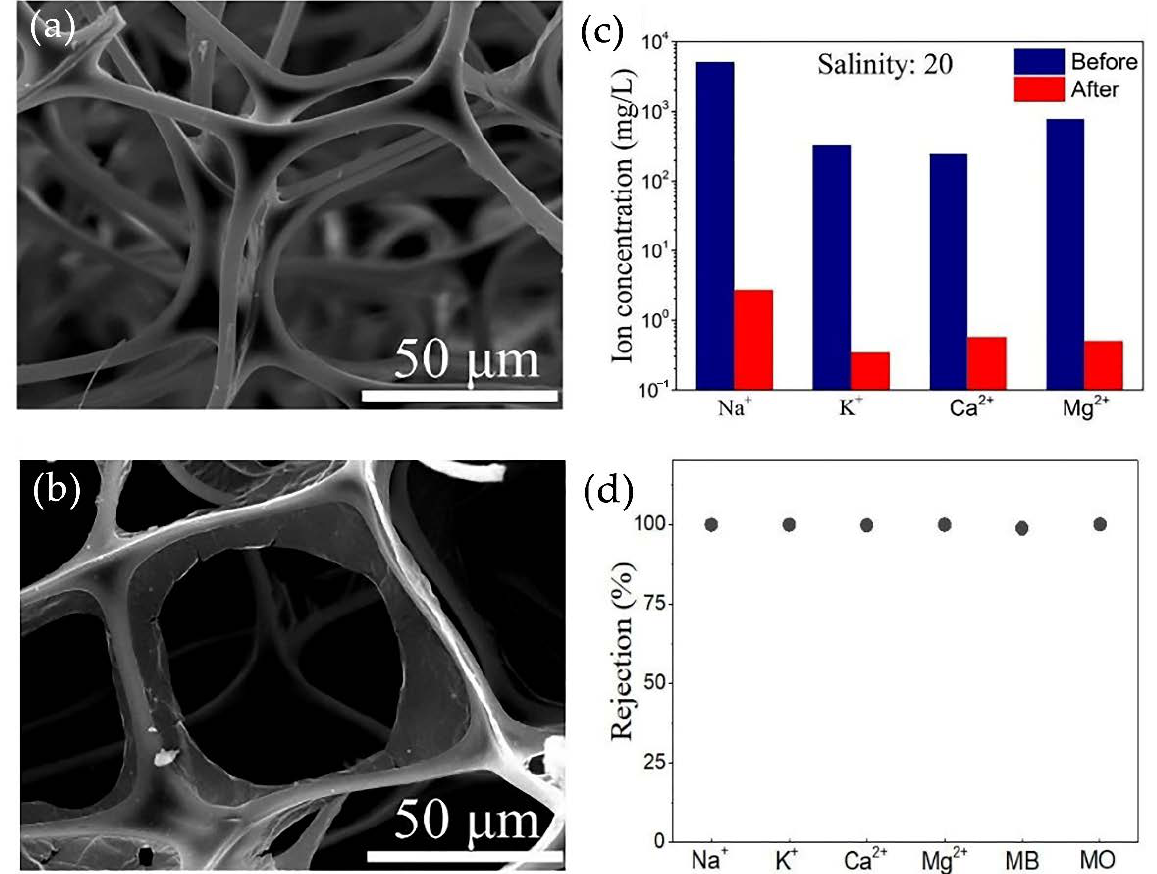
Figure 29. SEM images of melamine foam ( a ) before and ( b ) after immersion in a solution of polyvinyl alcohol and MXene suspension, followed by drying. ( c ) Concentrations of Na + , K + , Mg + , and Ca + cations in a standard seawater sample with a salinity of 20 before and after evaporation. ( d ) Degree of trapping of metal ions and dyes (methylene blue, MS, and methyl orange, MO). Reprinted with permission from [165] 2019 Royal Society of Chemistry.